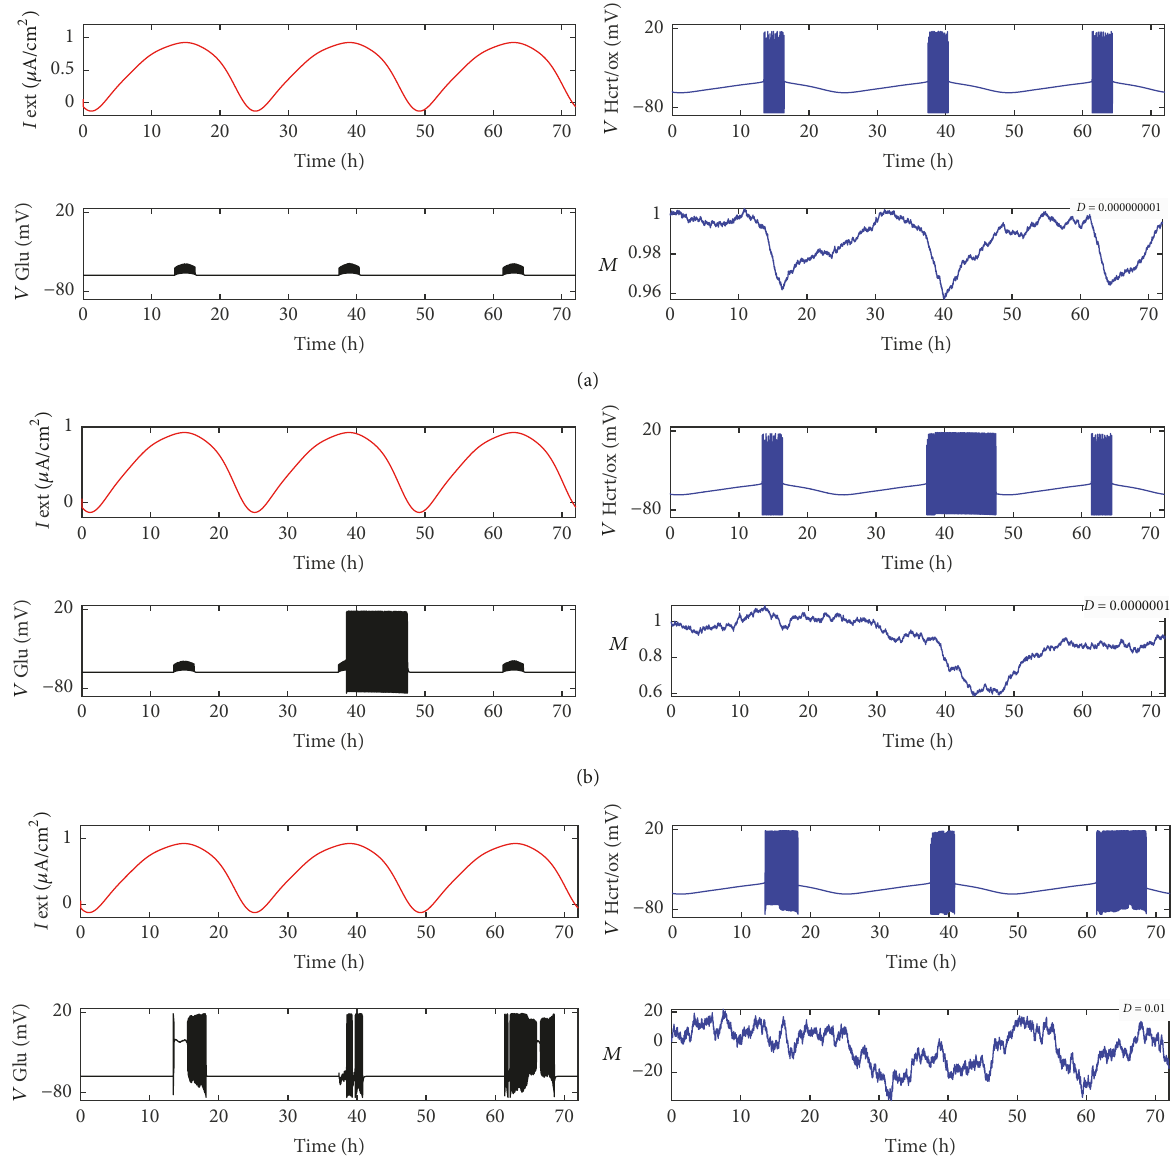
Figure 4: With the same subthreshold amplitude of external current input 𝐴 = 0.46 𝜇 A/cm 2 , the small noise intensity of the modulation function has weak effect on the regulation process, as shown in (a) for 𝐷 = 0.000000001 , but, for the bigger strength of noise, the function of regulation will lose its effectiveness ((b) for 𝐷 = 0.0000001 ), even damaging the function of the neurons themselves; the value of the modulation function becomes very bigger and randomly changes within − 40 ∼ 20 (c), all of which means that homeostatic regulation function of sleep-wake cycles is more sensitive to